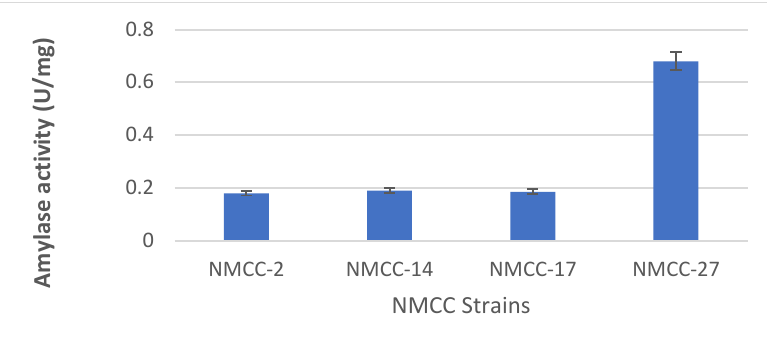
Figure 4. Amylolytic potential of the isolated LAB strains.